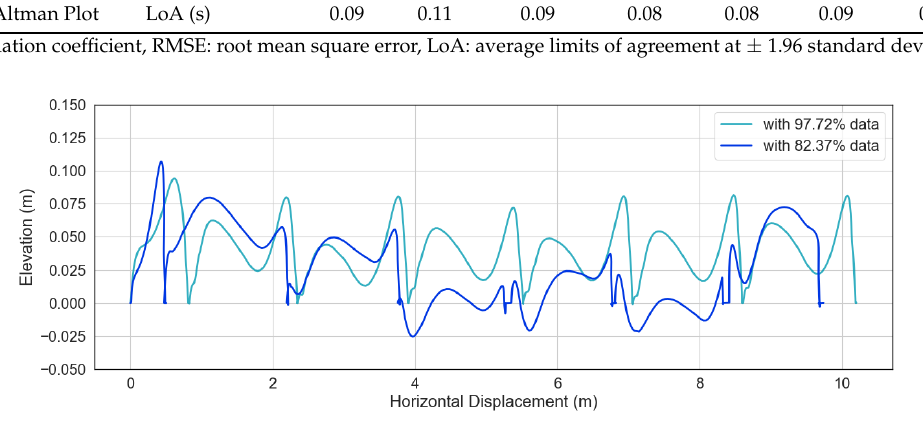
Figure 7. Disruption of the estimated stride trajectories due to data loss during Bluetooth